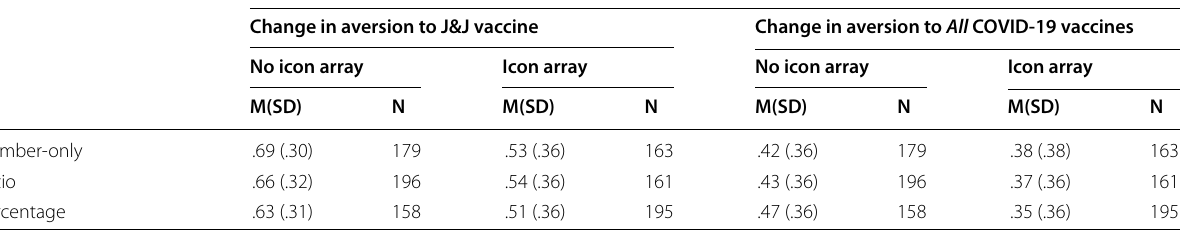
Table 2 Change in aversion toward vaccination by condition for experiments 1 and 2 Probability expression Experiment